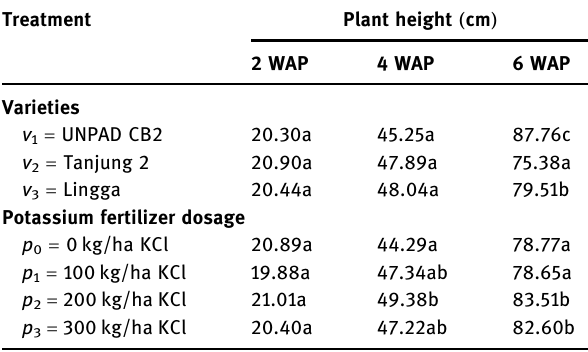
Table 2: E ff ect of dosage of potassium fertilizer and red chili vari - eties on plant height at 2, 4, and 6